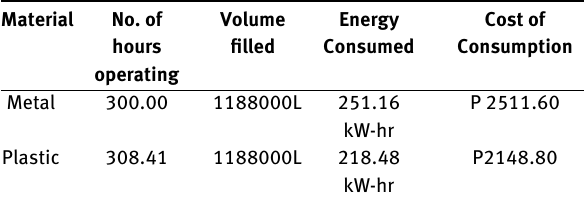
Table 3: Summary of Output and Consumption